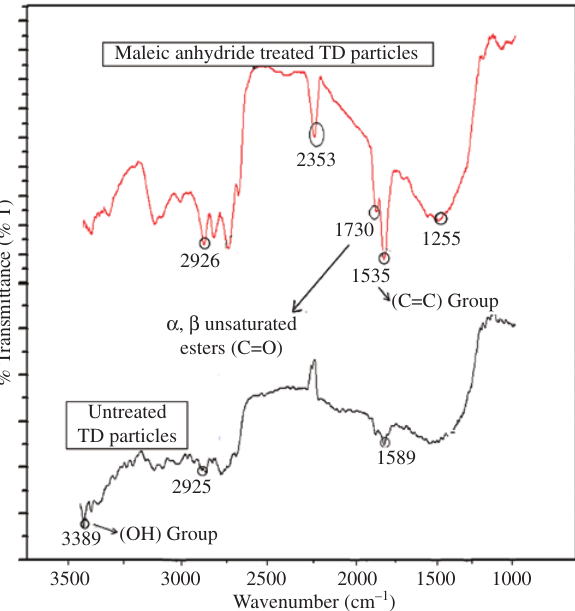
Figure 2: FTIR spectra of untreated and treated TD particles.